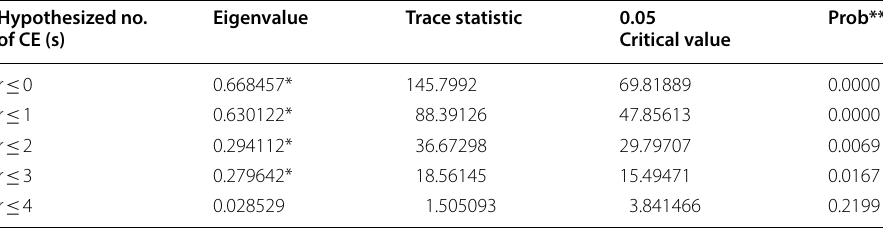
Table 9 Unrestricted co-integrated rank results